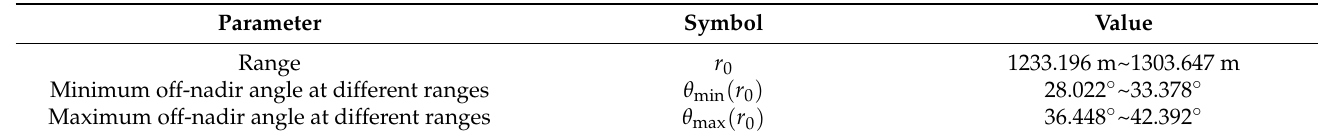
Table 6. Parameters of the selected region in experiment 1.